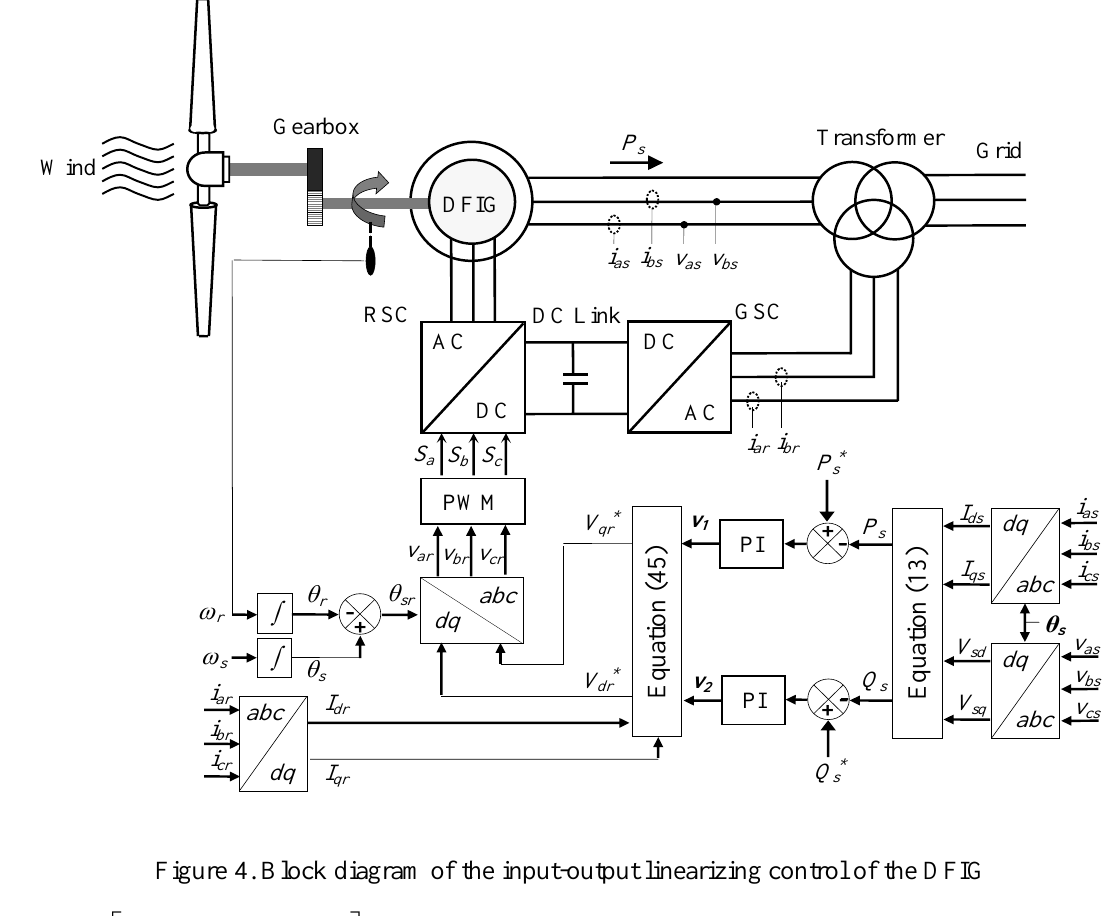
Figure 4. Block diagram of the input-output linearizing control of the